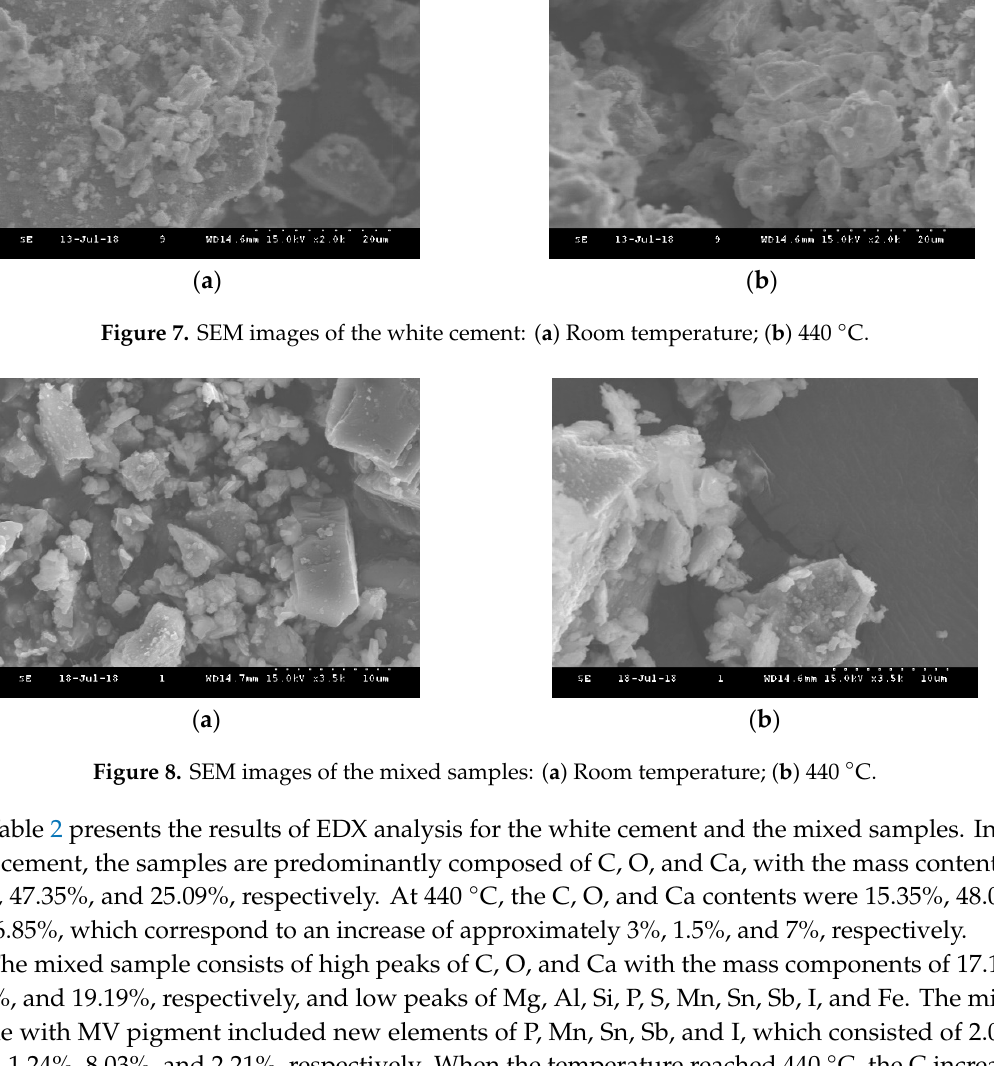
Table 2. EDX analysis of the white cement mixed samples—weight (%).